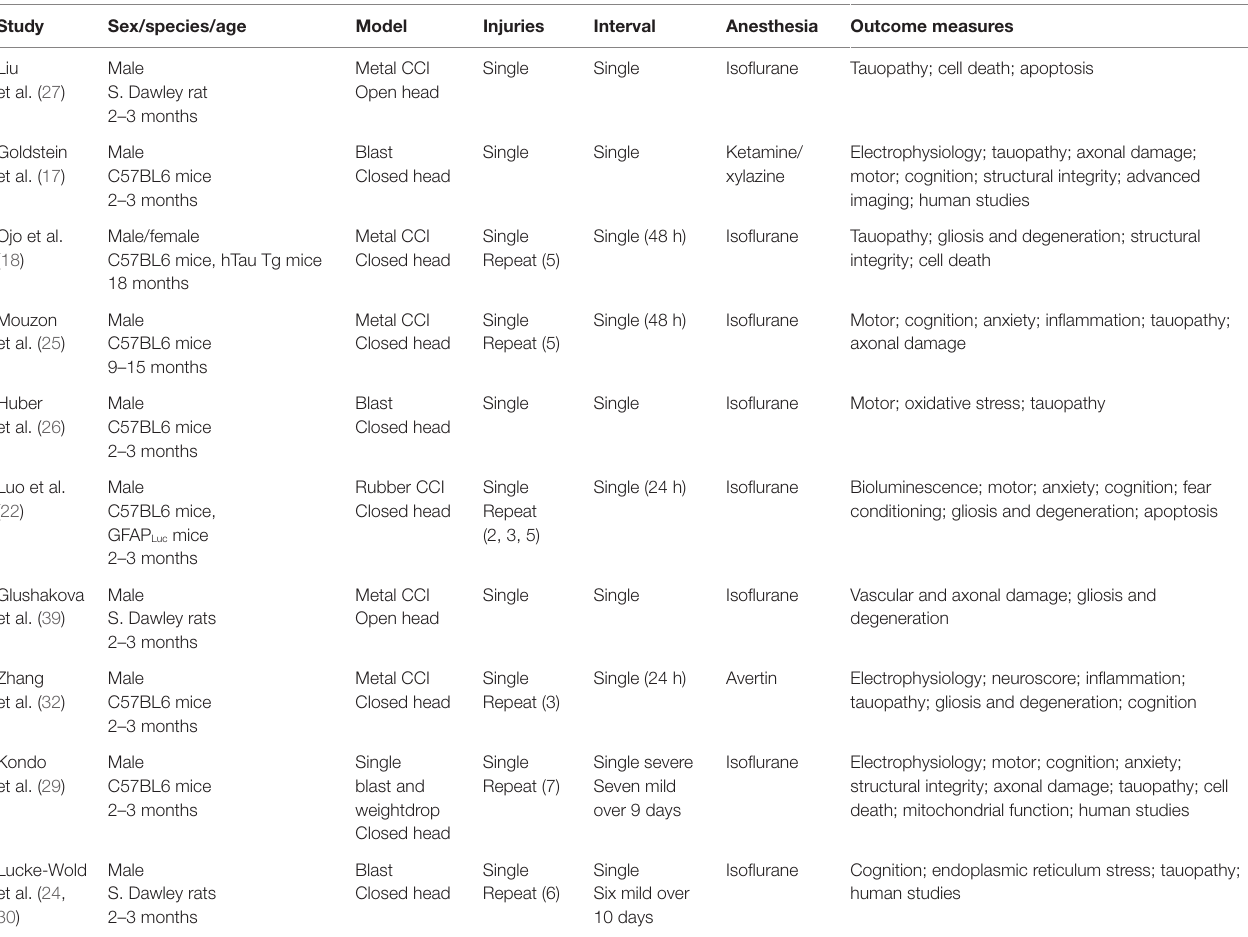
TABLe 1 | Chronic traumatic encephalopathy TBi models.